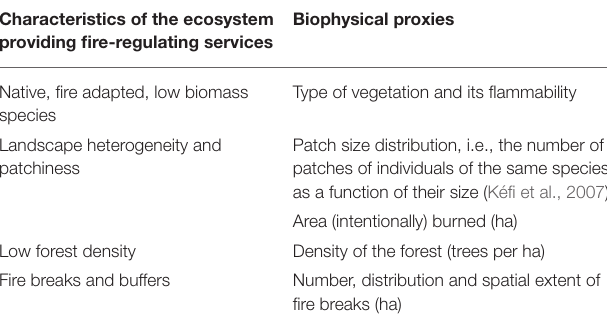
Biophysical proxies